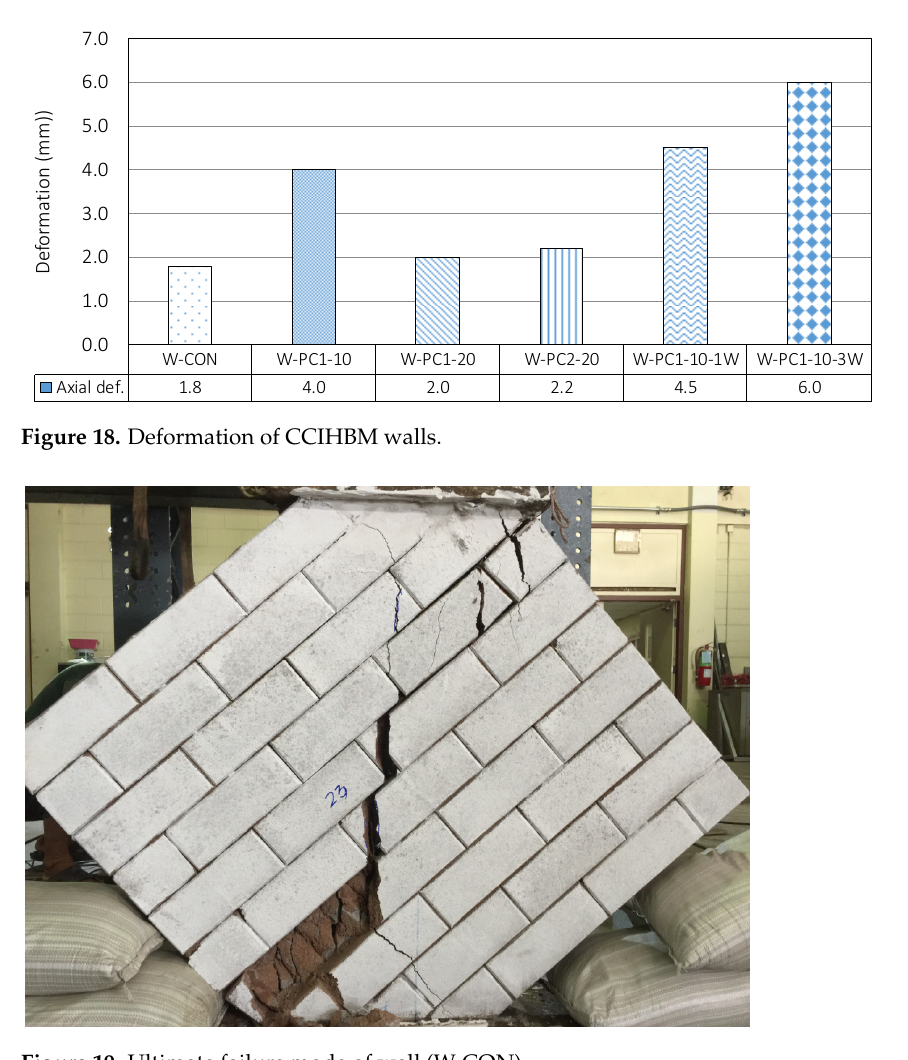
Figure 21. Failure of wall (W-PC2-20). Figure 22. Fracture of wire mesh.